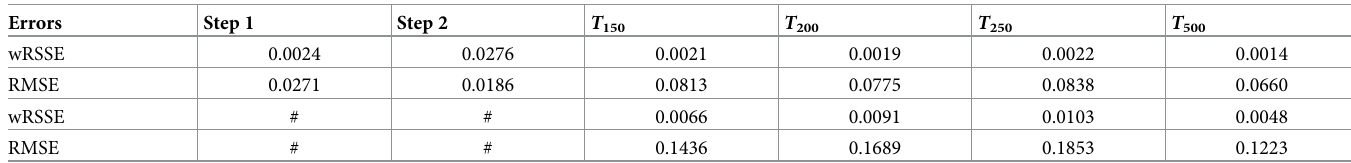
Table 3. Performance evaluation indexes of deterministic modeling for the buffered gene network. The columns T 150 , T 200 , T 250 and T 500 denote the periods of square inputs are 150, 200, 250 and 500 minutes. The symbol # indicates the lack of measured data with efficient